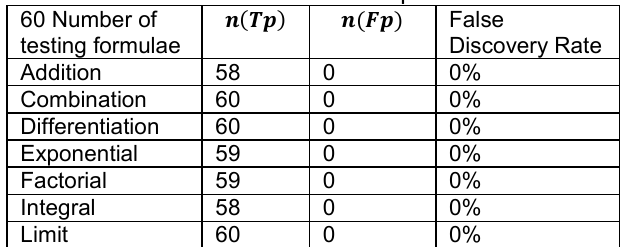
Table 18. The above tabulated value represents overall FDR Measure with Tensorflow from a document of 60 samples.